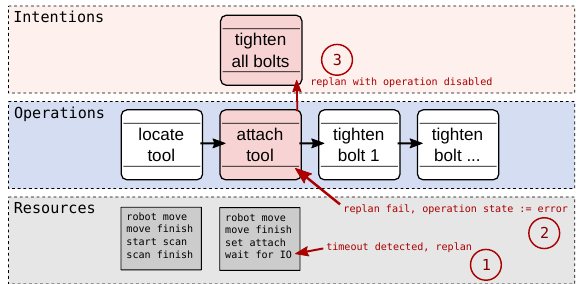
Figure 6. Propagating errors in the